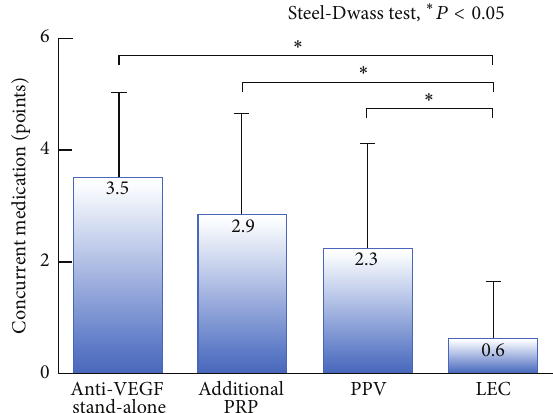
Figure 5: Number of concurrent medications according to NVG treatment received. LEC was associated with the lowest number of concurrent medications compared with other treatments. Concur- rent medications were weighted as follows: systemic acetazolamide, 2 points; eye drops, 1 point; and mixed eye drops, 2